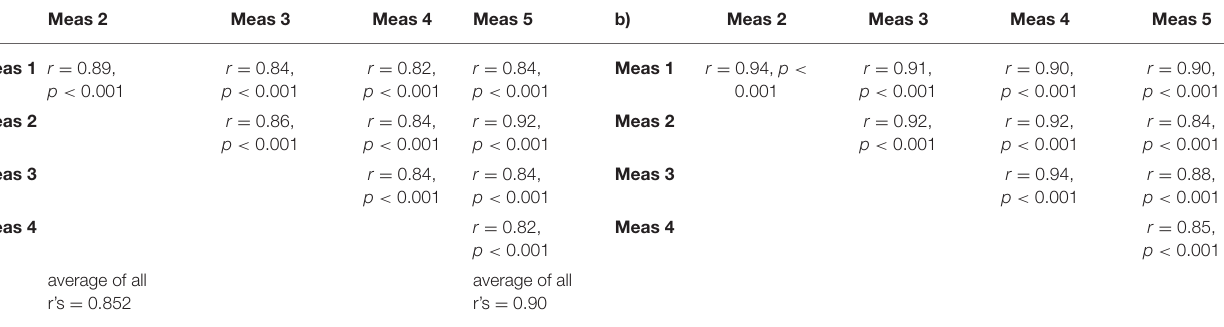
TABLE 2 | Results for intra-observer over the repeated assessments (measurements 1–5, “Meas”) reliability using Spearman’s rank correlation coefficients (r).